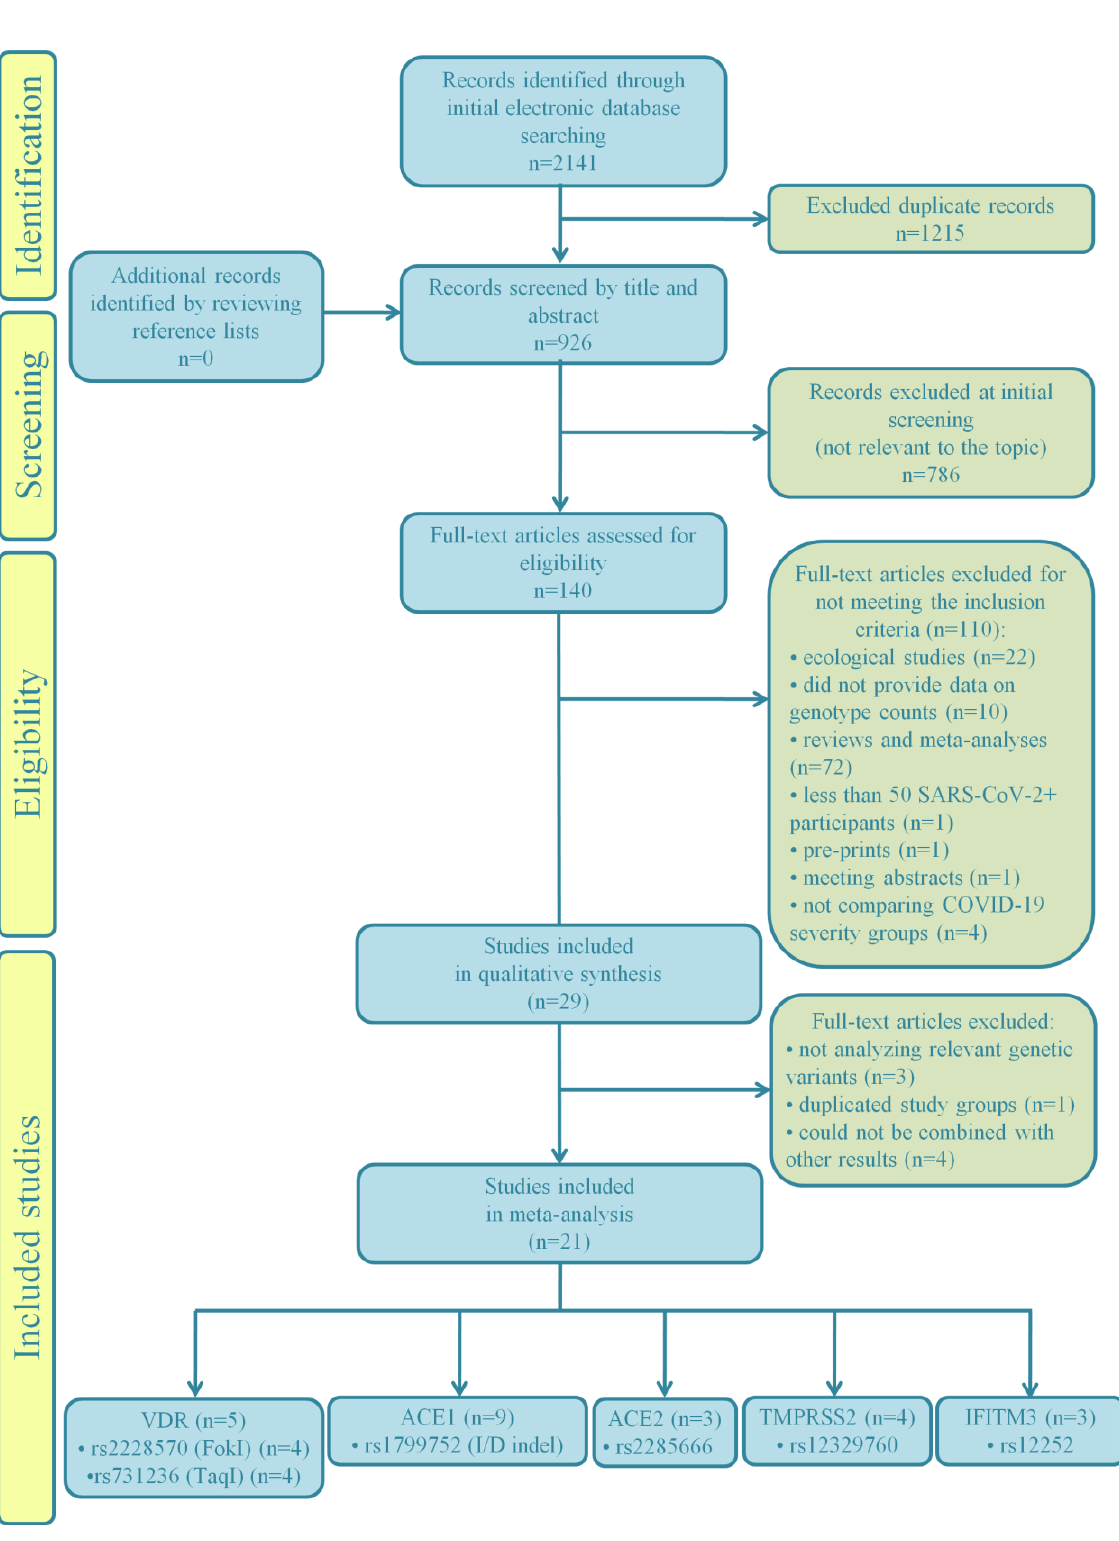
Figure 1: Flowchart of the study selection